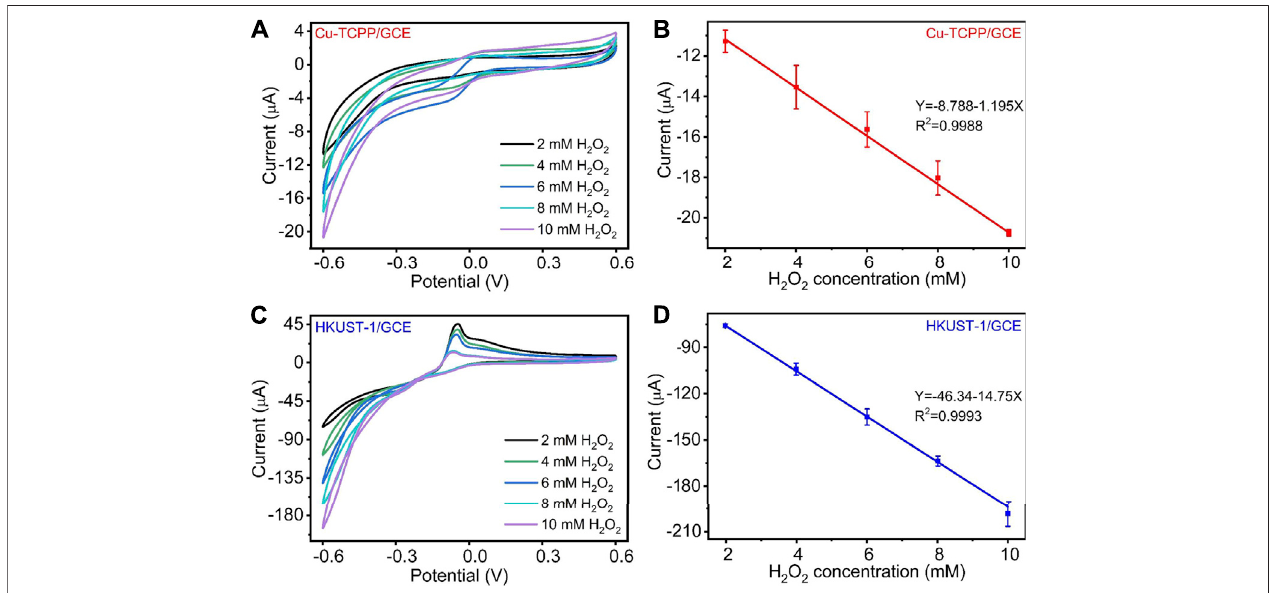
FIGURE 4 | (A) CV curves of Cu-TCPP/GCE for different H 2 O 2 concentrations (2, 4, 6, 8, and 10 mM) with a scan rate of 100 mV/s. (B) The linear relationships betweenthe electrochemicalpeak current and H 2 O 2 concentration ofCu-TCPP/GCE. (C) CV curvesofHKUST-1/GCE for different H 2 O 2 concentrations(2, 4,6, 8,and 10 mM). (D) The linear relationships between the electrochemical peak current and H 2 O 2 concentration of